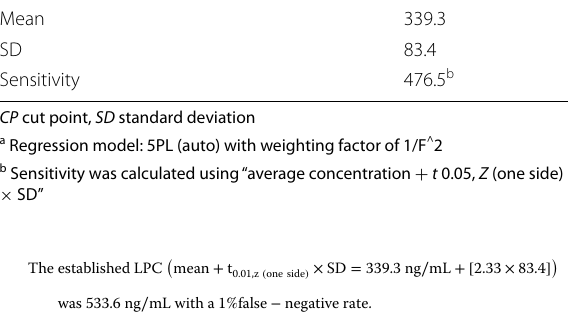
Quality control